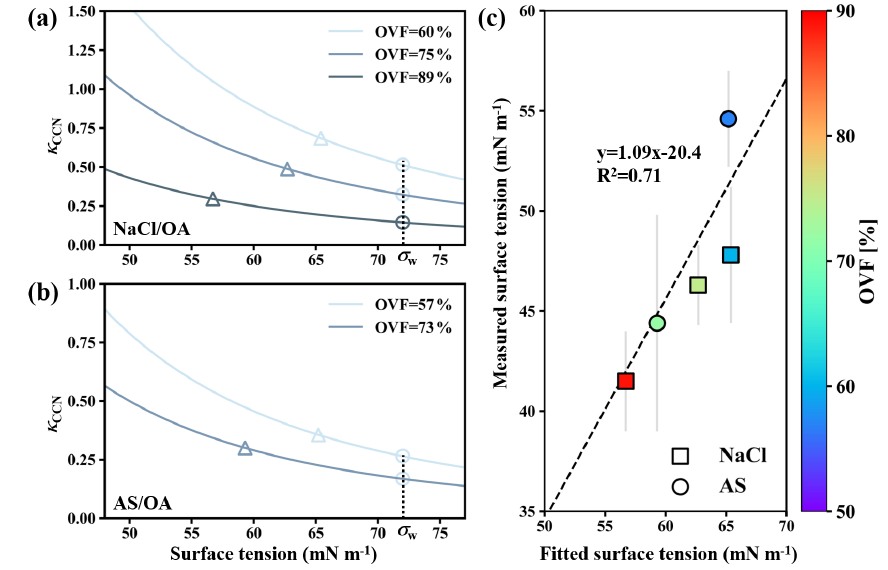
Figure 7. κ CCN versus assumed surface tension for (a) NaCl–OA and (b) AS–OA systems according to solubility-involved Köhler model presented by Petters and Kreidenweis (2008). The triangles and circles in (a) and (b) represent the measured κ CCN and predict κ CCN by solubility-involved Köhler model. Closure between fitted surface tensions and measured surface tensions (c) . σ w represents water surface tension (72mNm − 1